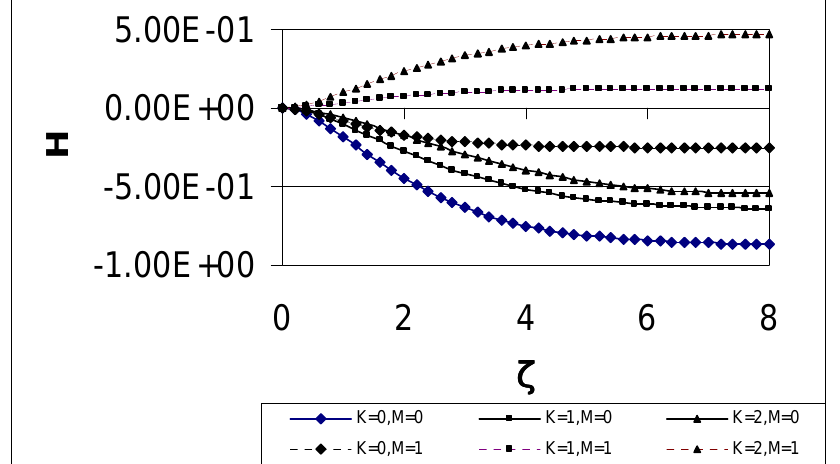
Fig. 5. Effect of the porosity parameter M and the non-Newtonian parameter K on the profile of H.